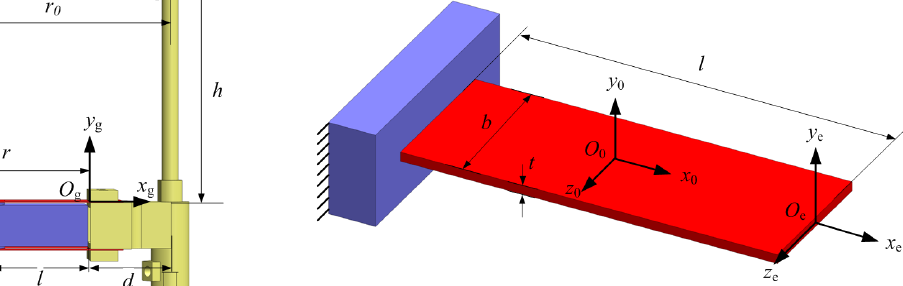
Figure 4. Front view of a flexible arm.